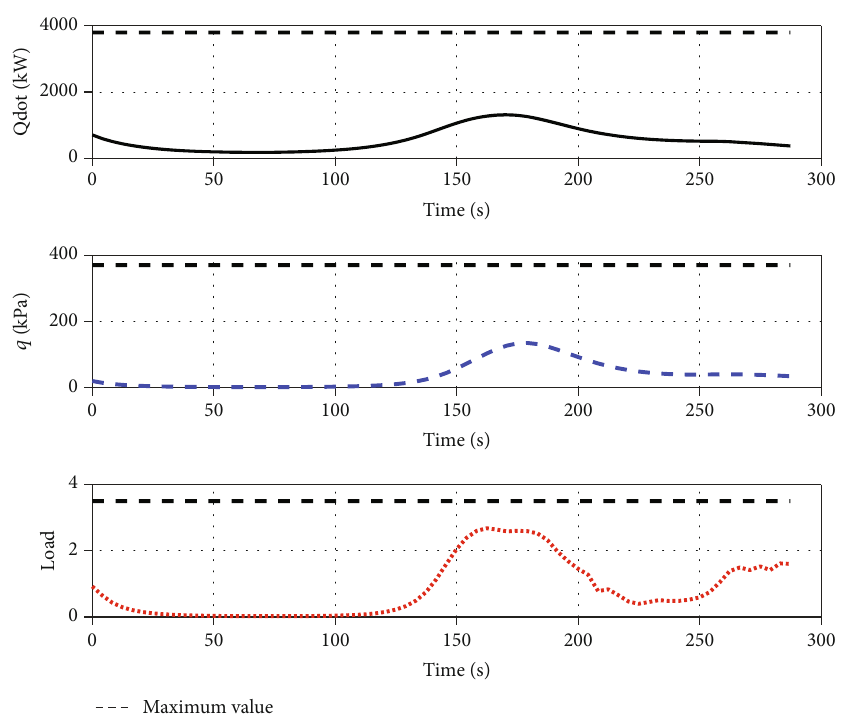
Figure 5: Path constraints for convergent solutions.